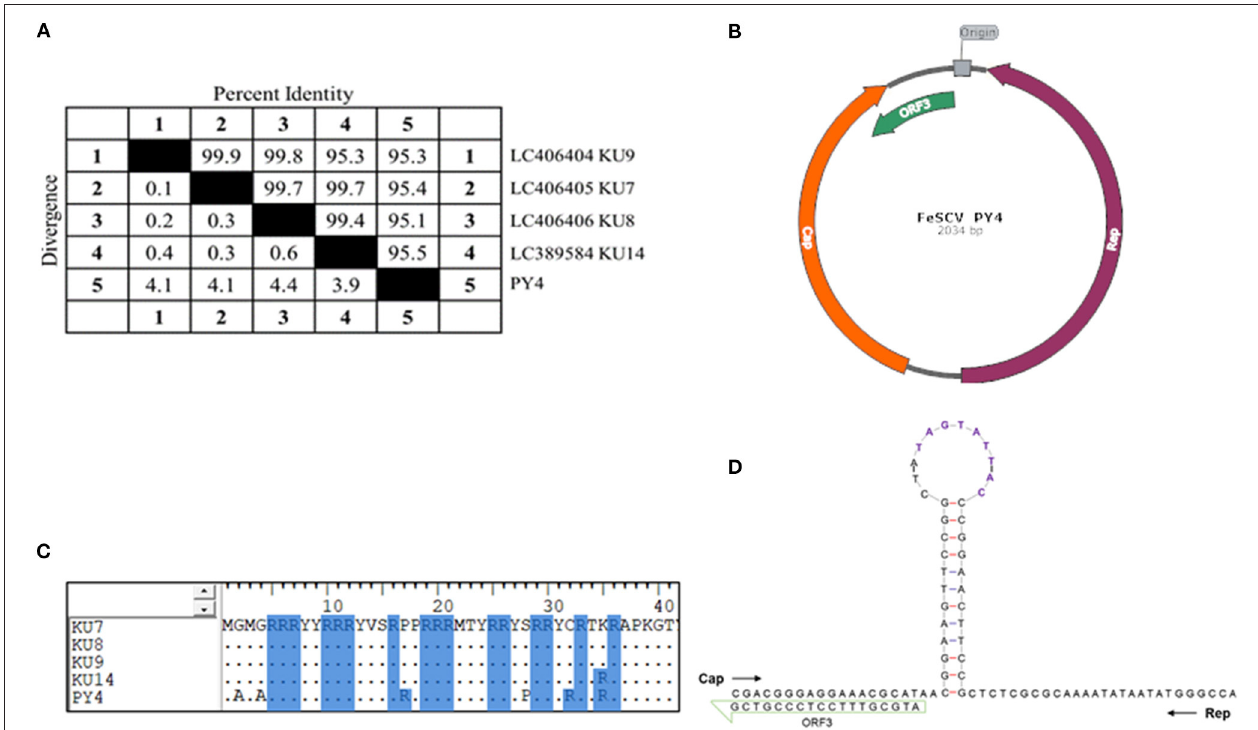
FIGURE 1 | The genomic characteristics of FeSCV-PY4. (A) Whole-genome homology analysis of PY4 with other Japanese isolates. (B) The genome map of the PY4 strain. Cap is indicated by an orange arrow, Rep by a purple arrow and ORF3 by a green arrow. (C) Amino acid analysis of the FeSCV N-terminus. Arginine residues are highlighted with a blue background. (D) The stem-loop structure of the PY4 strain. The conserved canonical non-anucleotide motif (5 ′ TAGTATTAC) is shown in